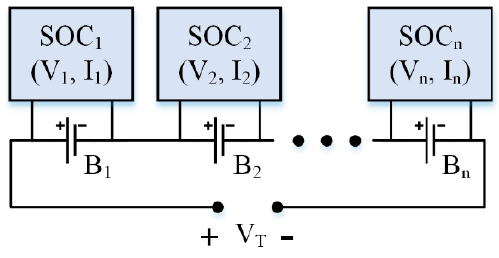
Figure 6. SOC estimation process from